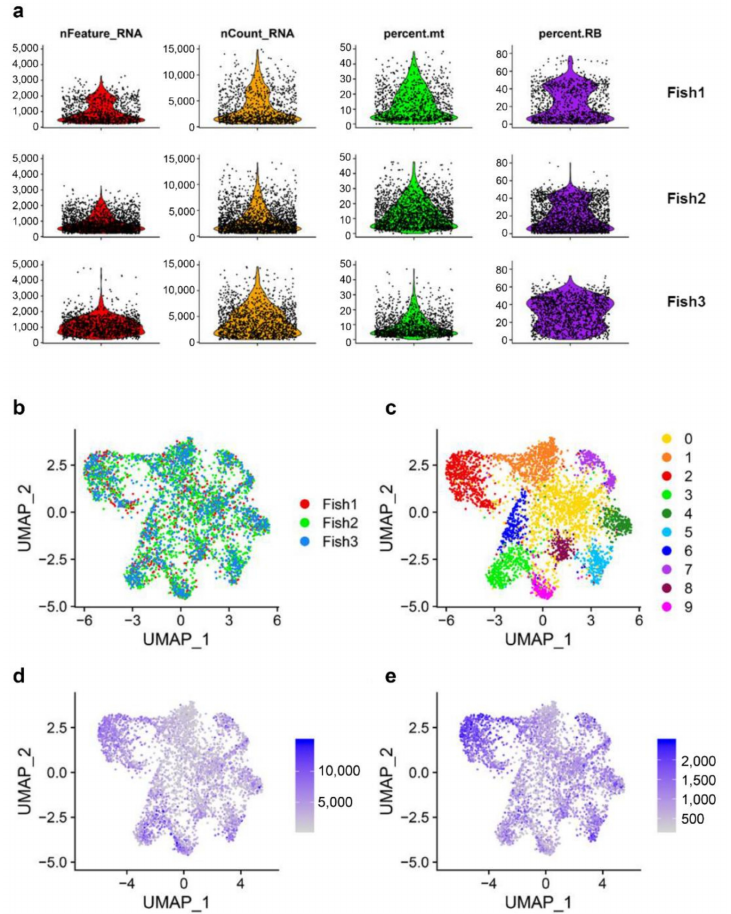
Figure 1. Single cell sequencing quality check and cell projection analysis. ( a ) Quality check of single cell sequencing results. The figure shows the total number of genes (nFeature_RNA), the total number of reads (nCount_RNA), the percentage of reads mapping mitochondrial genes (percent.mt) and the percentage of reads mapping ribosomal proteins (percent.RB) per cell in each individual fish. UMAP visualization of cells integrating data from the three individual fish ( b ); defining clusters of cells with similar transcriptional identities ( c ); showing the total number of reads identified for each cell ( d ) or the total number of genes identified for each cell ( e